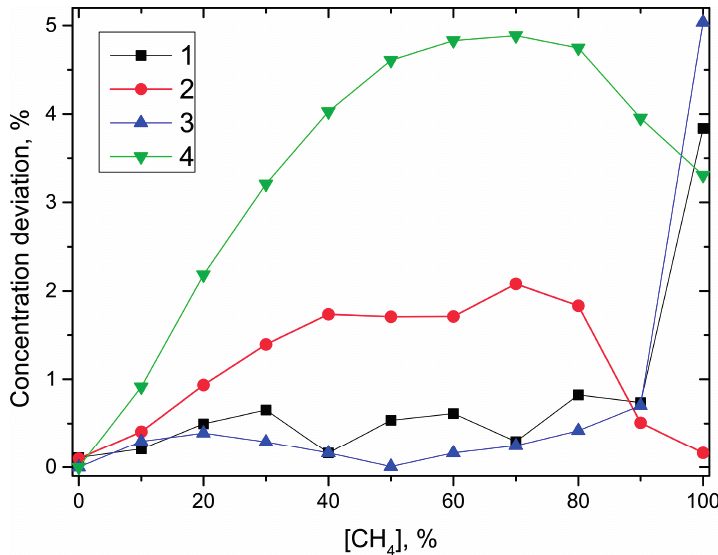
Figure 8. Concentration deviation in % of the target gas concentration for the QEPAS sensor with humidified CO 2 (1) and dry N 2 (2) and for the conventional sensor with humidified CO 2 (3) and dry N 2 (4) in comparison to the dry CO 2 background gas